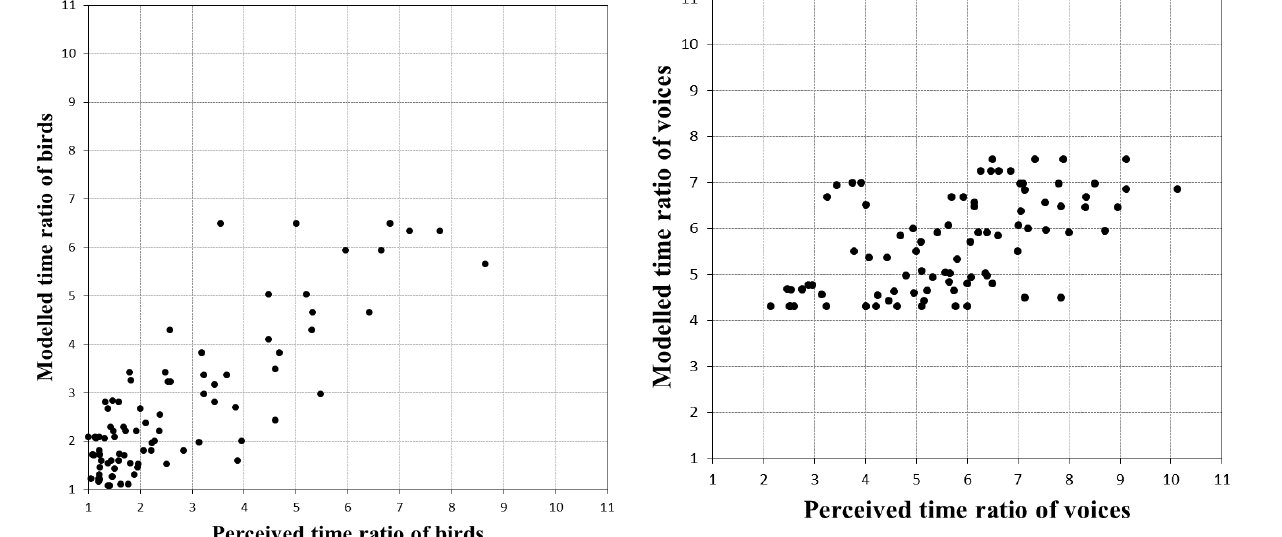
Figure 7: Relation between the perceived time ratio of birds and this time ratio modelled by the Eq. (11).